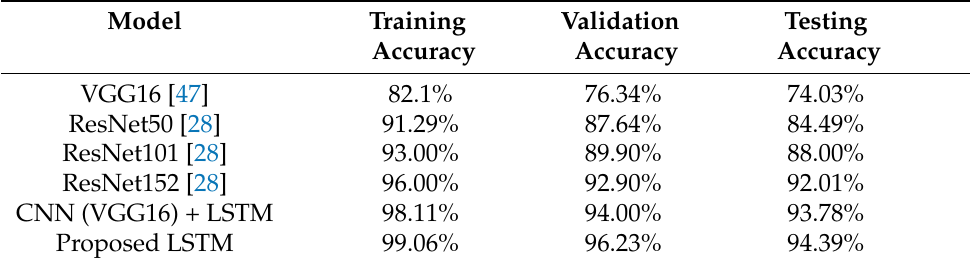
Table 5. Training, Validation, and Testing accuracies of the final model: the model was trained and tested against several methods. We have trained the proposed dataset with the VGG16 [47], ResNet [28], and multimodel CNN+LSTM architectures. The proposed LSTM with given hyper- parameters offered the highest validation and testing